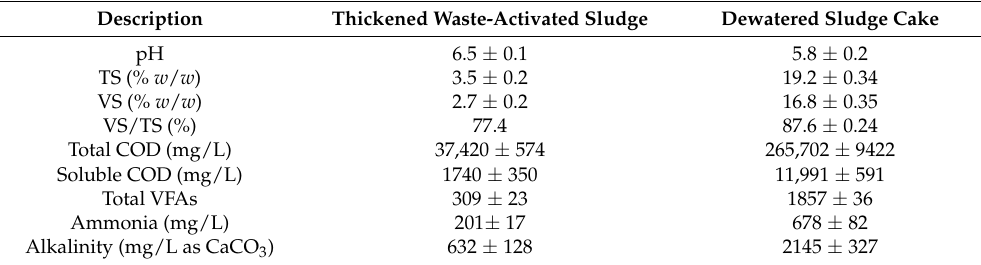
Table 2. The characteristics of the municipal sludge used in this research